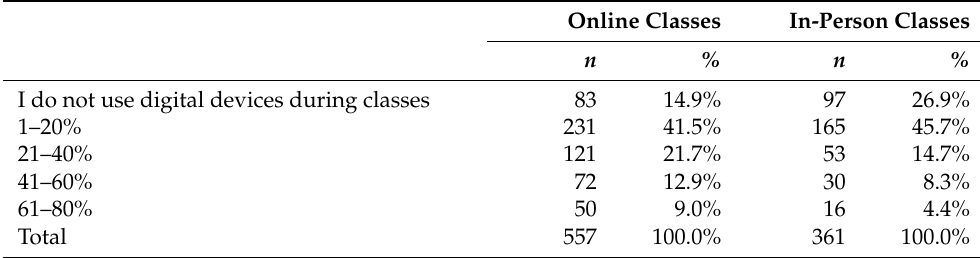
Table 4. If you use your digital device for reasons not related to school during class, what percentage of class time do you spend on your devices?